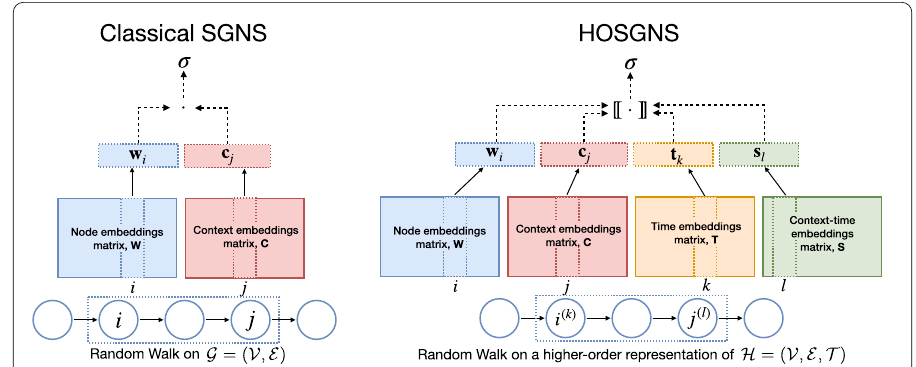
Figure 2 Representation of SGNS and HOSGNS with embedding matrices and operations on embedding vectors. Starting from a random walk realization on a static graph G = ( V , E ), SGNS takes as input nodes i and j within a context window of size T , and maximizes σ ( w i · c j ). HOSGNS starts from a random walk realization on a higher-order representation of time-varying graph H = ( V , E , T ), takes as input nodes i ( k ) (node i at time k